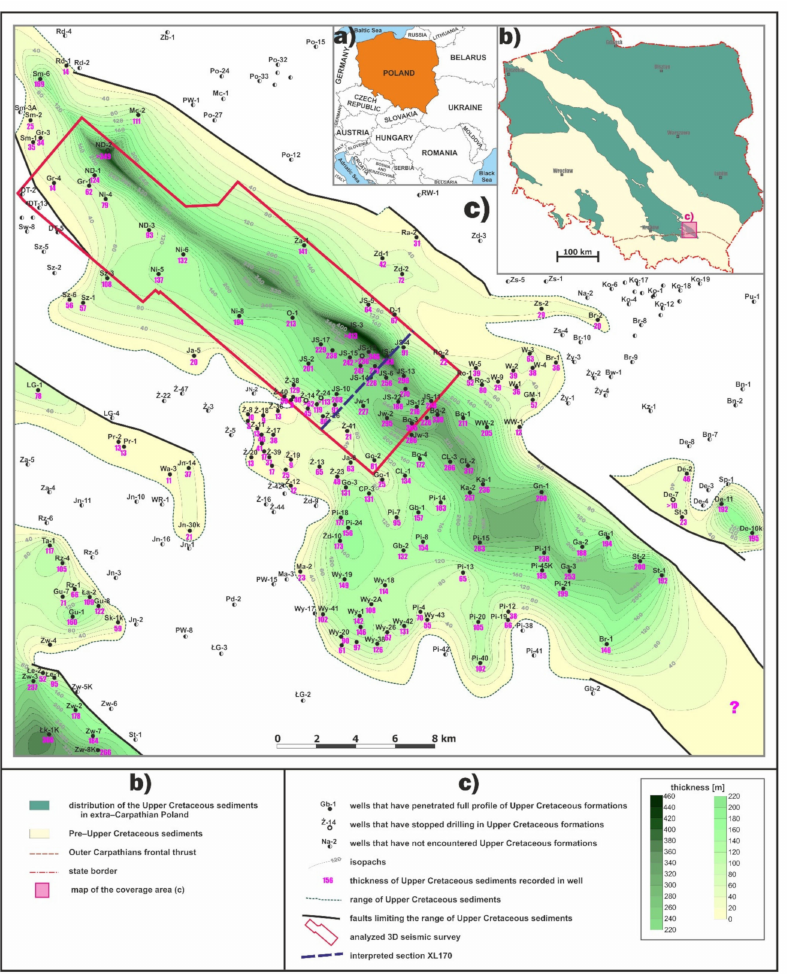
Figure 1. Location of the study area: ( a ) generalized outline of central Europe; ( b ) location of the study area (pink rectangle) in relation to the distribution of the Upper Cretaceous formations in extra-Carpathian Poland (modified after Walaszczyk et al., 1999 [43]); ( c ) isopach map of the Upper Cretaceous formations in the study